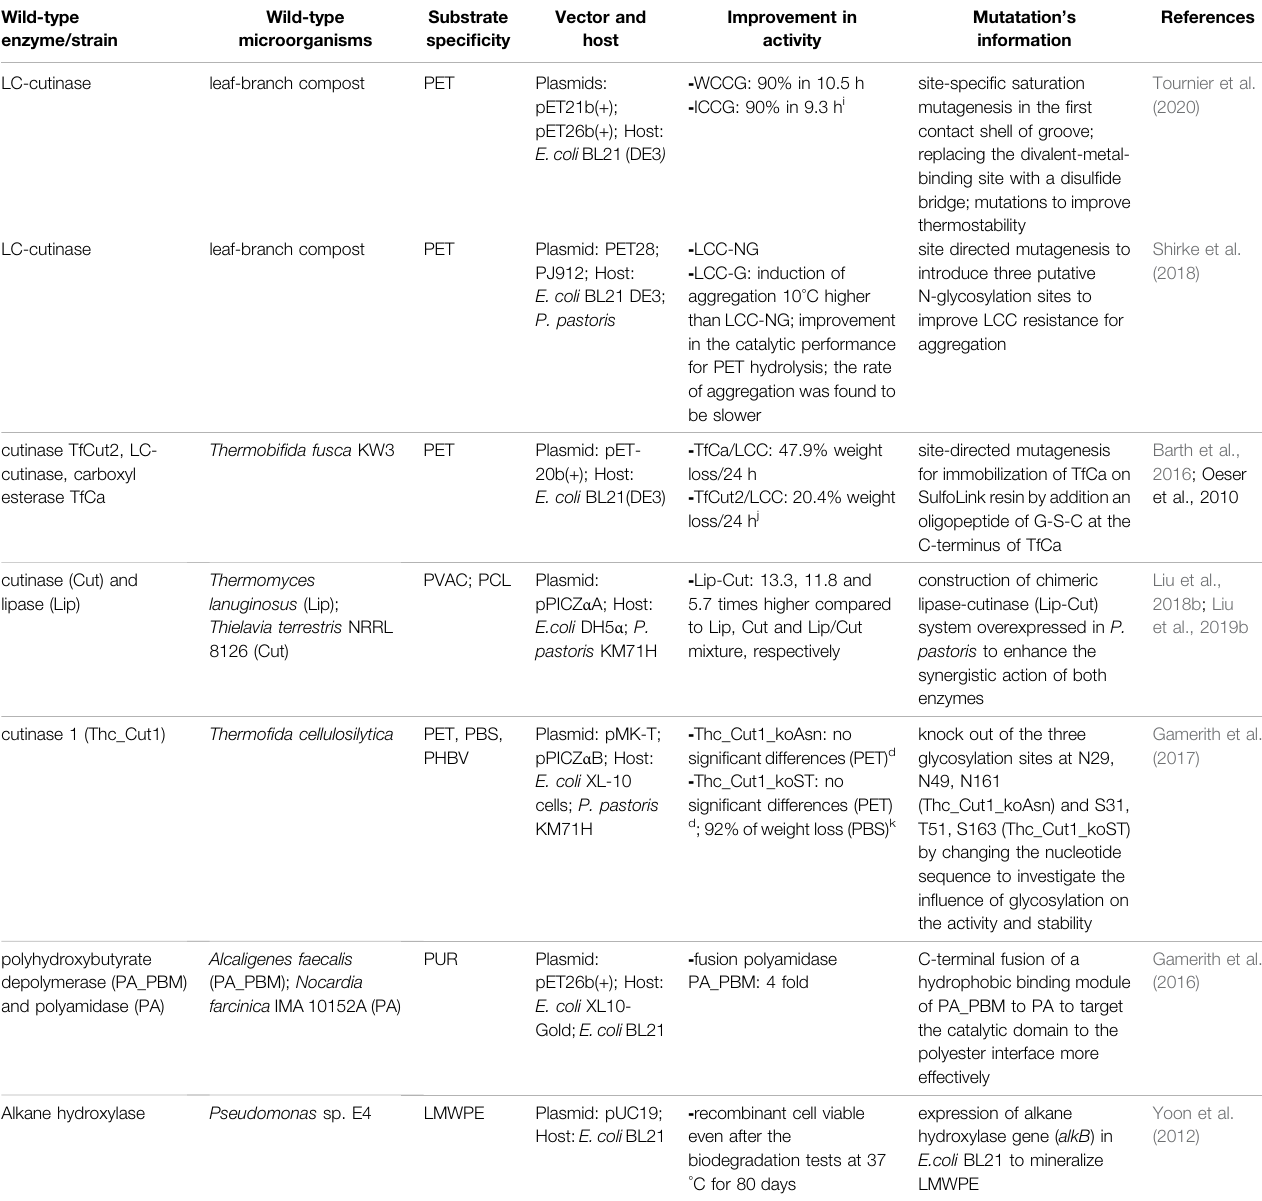
TABLE 1 | ( Continued ) Genetic modi fi cations of enzyme structure for enhancement of biodegradable abilities towards